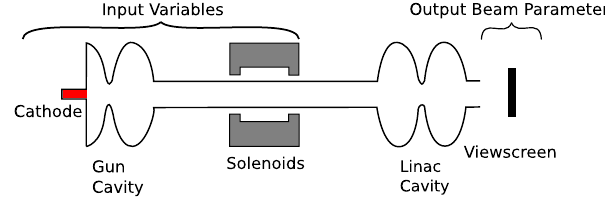
action.FIG. 1. Schematic view of the electron gun; the input variables are the parameters of the cathode, solenoids, and gun cavity. The output beam parameters can also be measured in the real